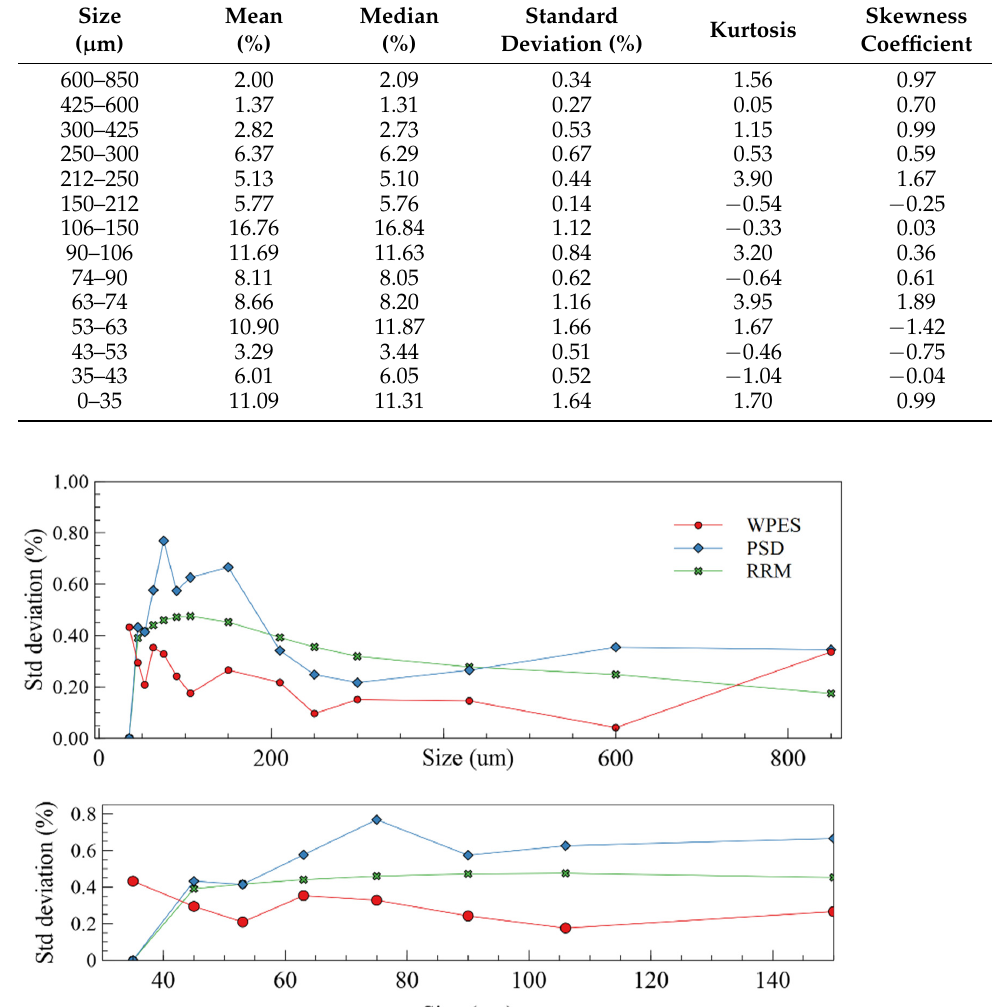
Table A7. Descriptive statistics of the 12 min test for the partial detainees with 95% confidence interval.